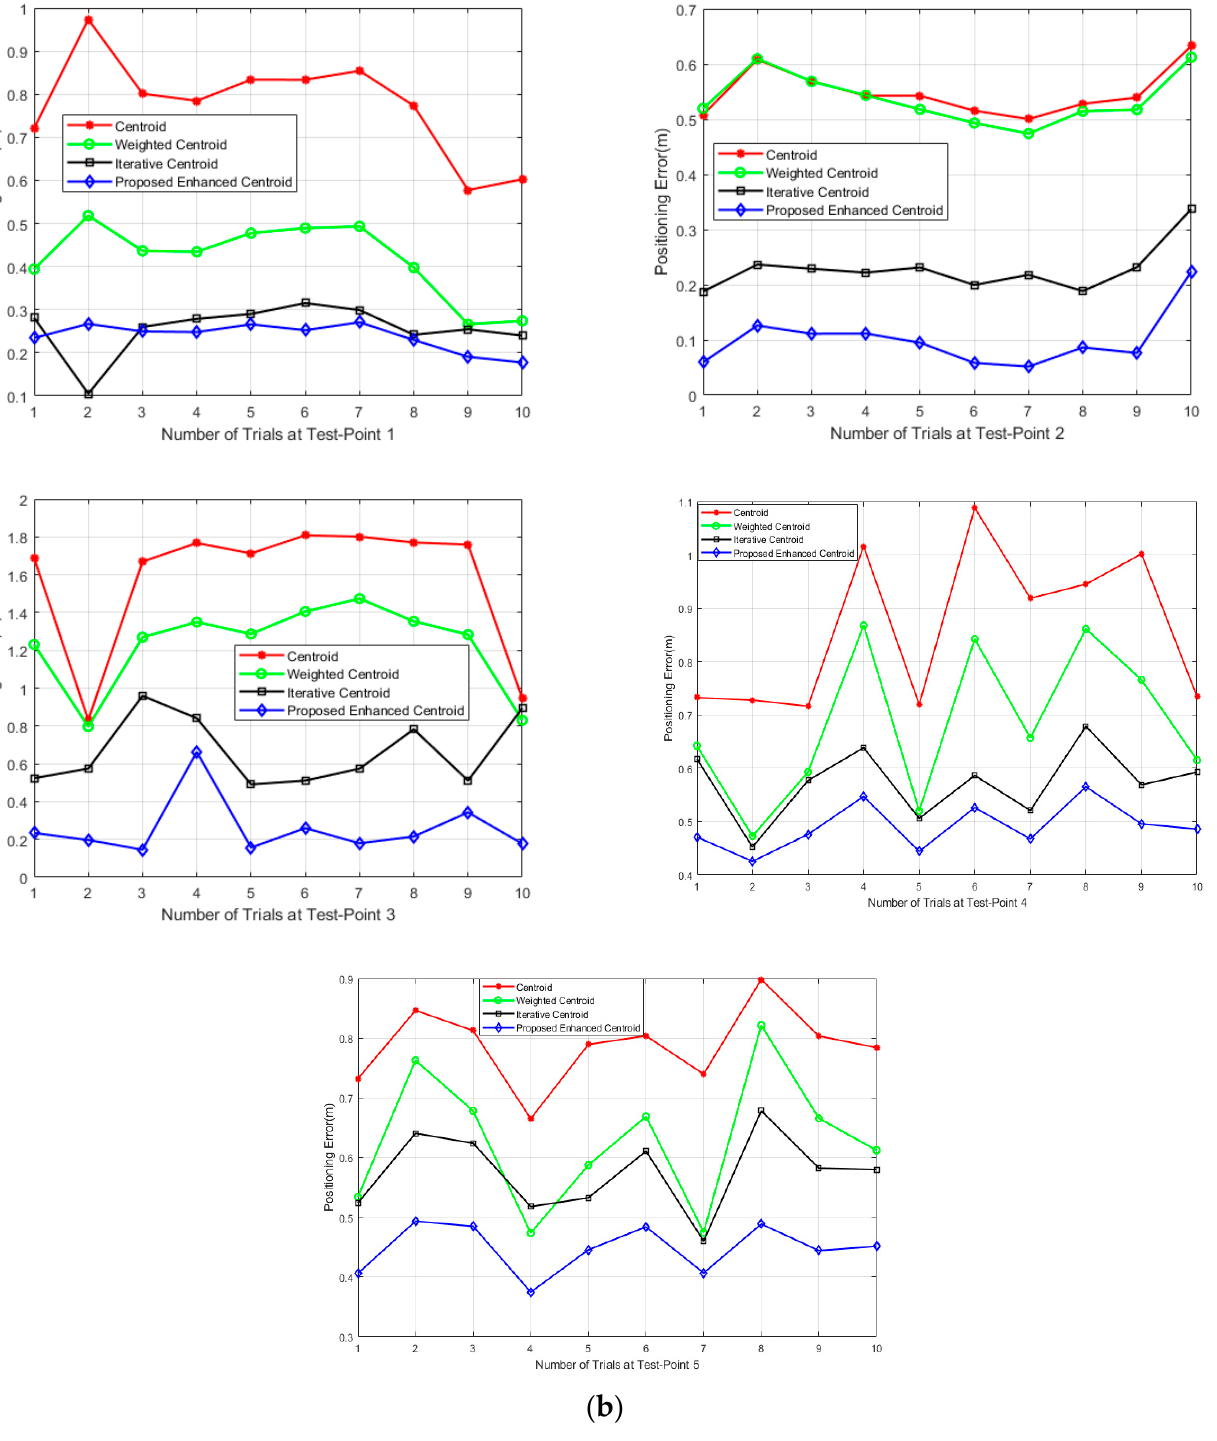
Figure 13. Positioning error comparison of the proposed positioning technique and the other positioning algorithms deploying the average RSSI filter at 5 test points for 10 trials: ( a ) The office room; ( b ) The corridor.